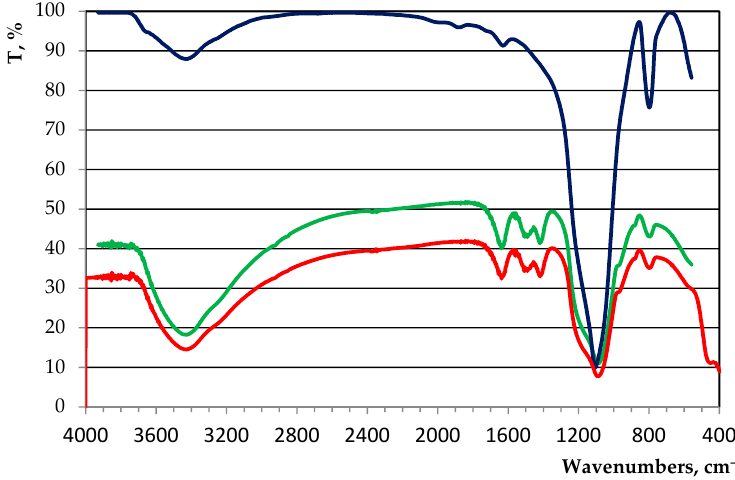
Figure 1. IR spectrum of the crystal phase of the studied sludge.